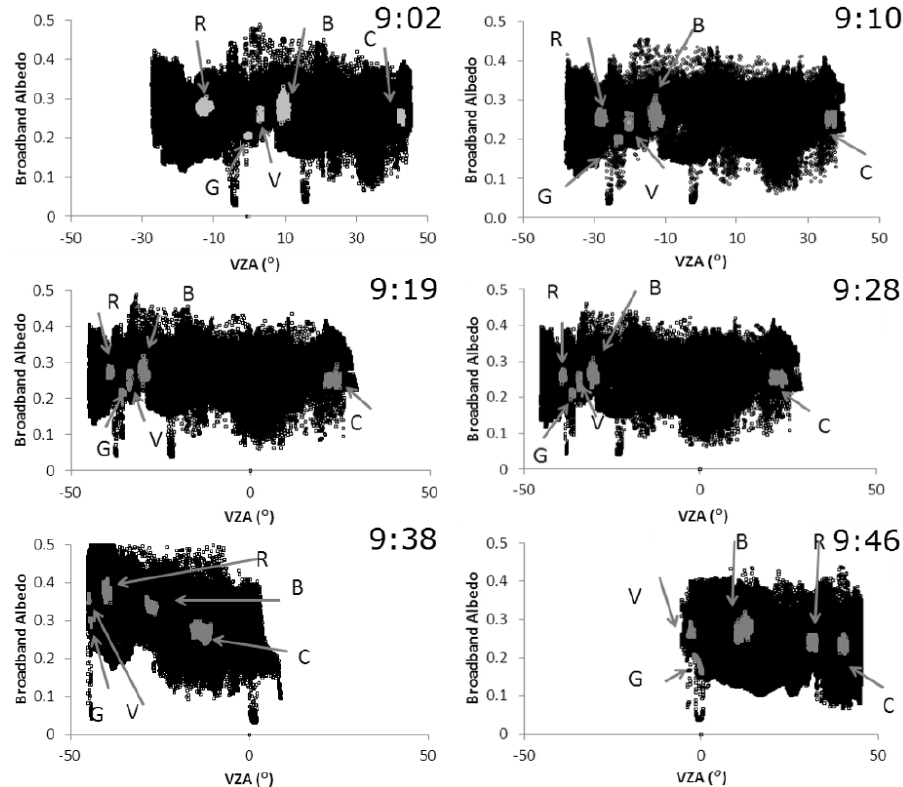
Figure 10. Integrated albedo as a function of the VZA for the area overlapped by the flights on 25 July 2012 at an altitude of 2000 m with a 5-m spatial resolution. The plot for each flight is identified by the UTC time of the flight. Some areas of the image are marked in grey for comparison: B = Barley, C = Camelina, G = Green Grass, R = Reforestation, V = Vineyard.